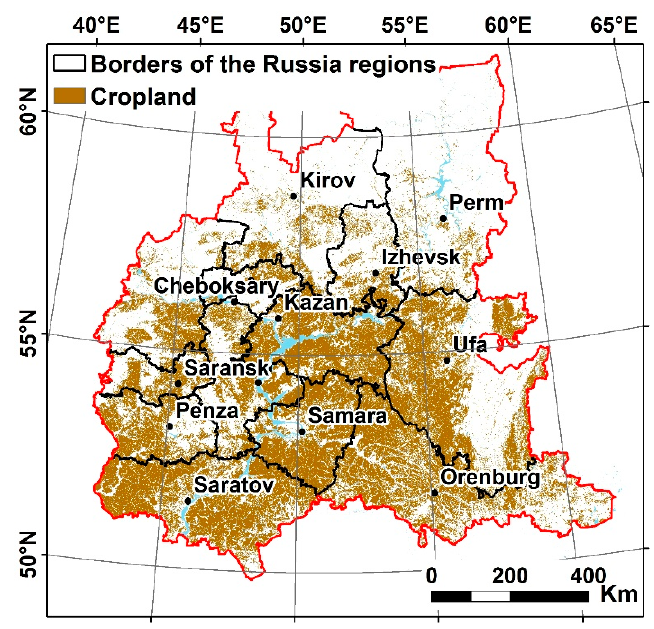
Figure 7. Volga Federal District croplands based on processing of MODIS vegetation indices time-series.